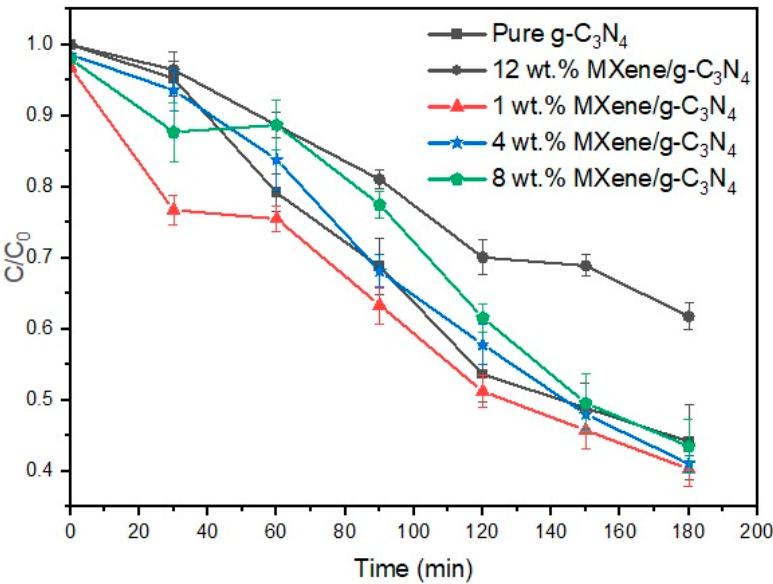
Figure 9. Photocatalytic degradation of methylene blue using MXene/g-C 3 N 4 heterostructure photocatalysts prepared with different amounts of MXene loading.